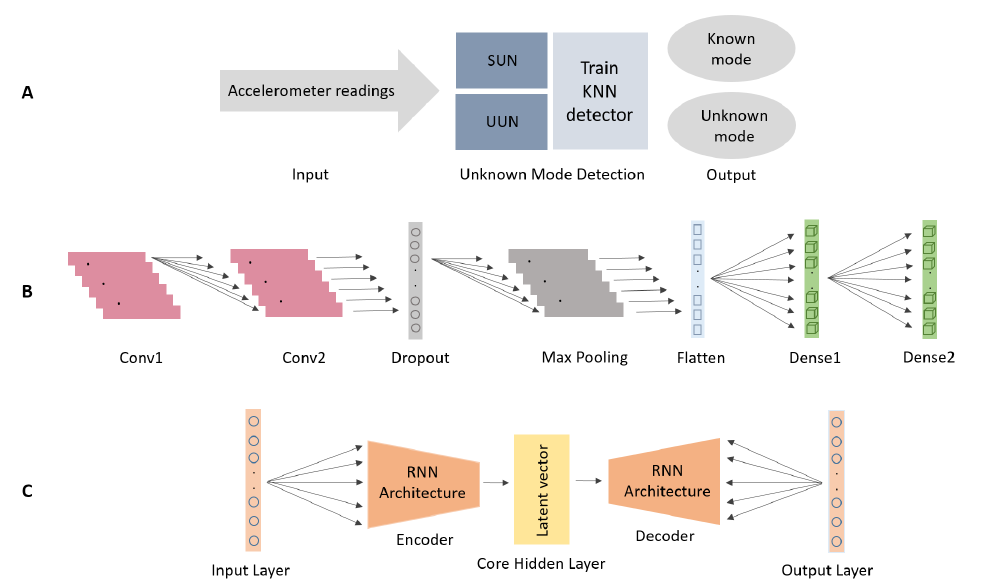
Figure 2. Proposed approaches for unknown modes detection using the smartphone’s accelerometers. ( A ) SUN and UNN with a KNN for separately modelling the unknown modes networks, ( B ) SUN network architecture used in training, and ( C ) UUN network architecture used in training. Table 1. Comparison between approaches in terms of training data.